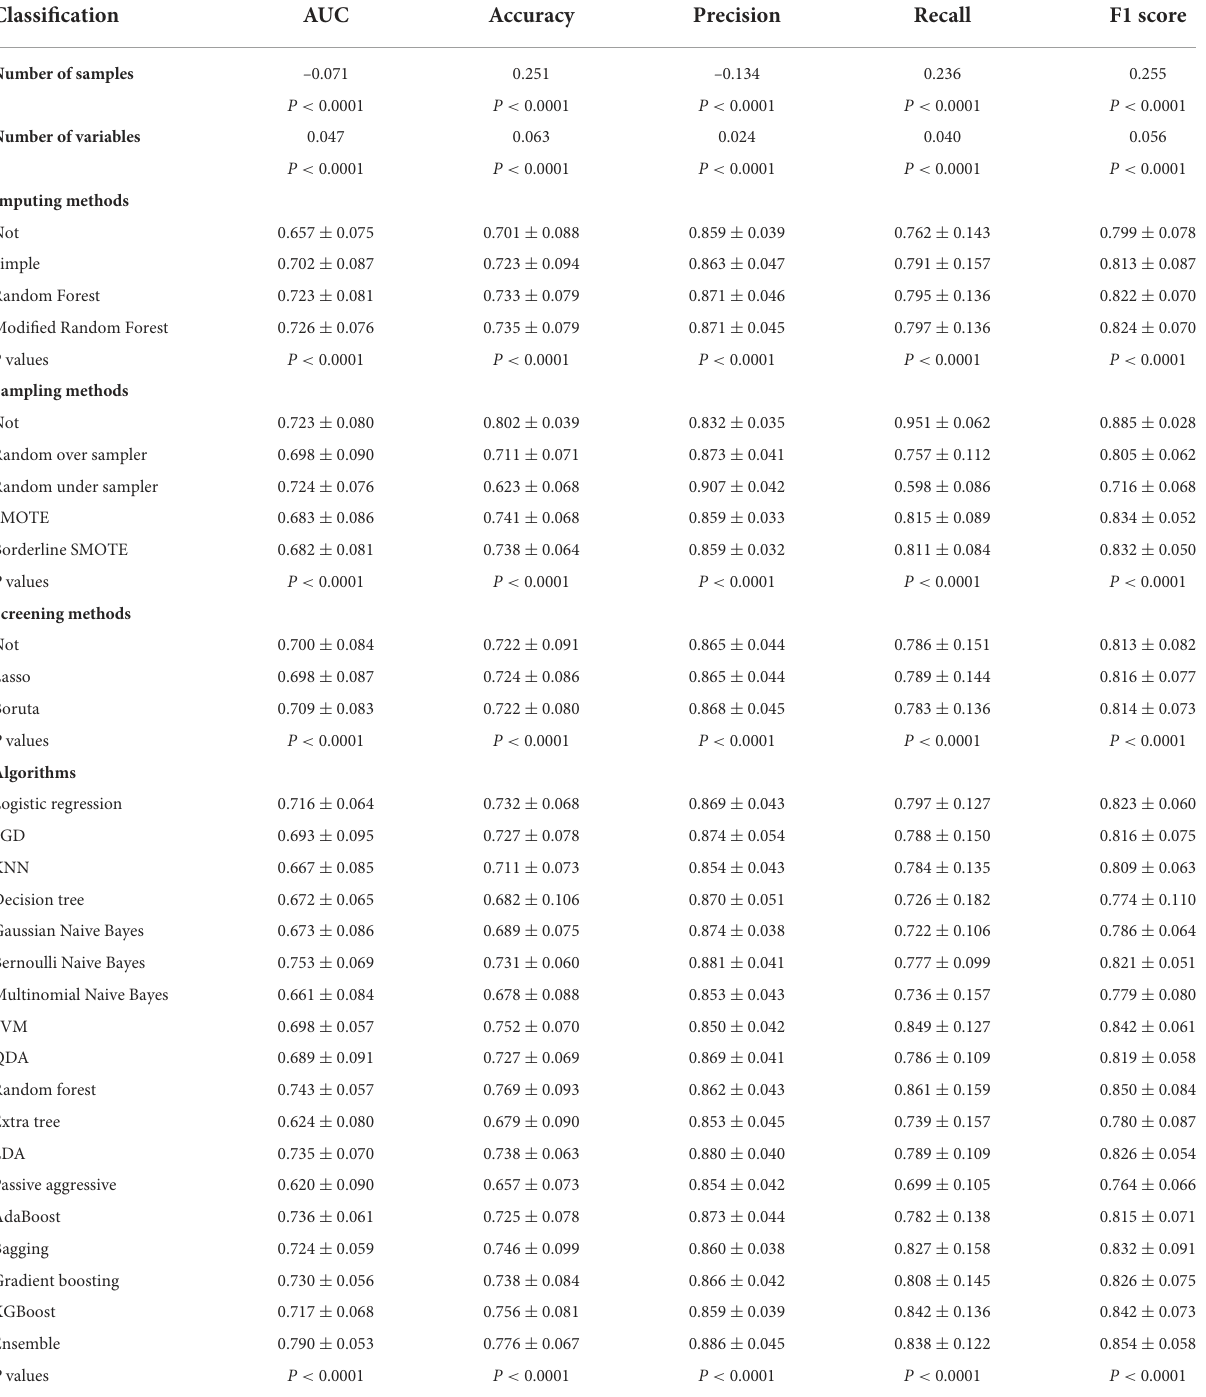
TABLE 4 The results of univariate analysis (¯x ±